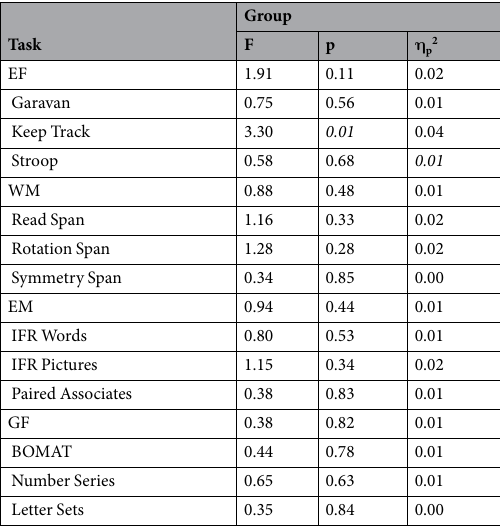
Table 1. ANCOVA Results for Constructs and Individual Transfer Tasks. Note: Values in italics indicate significant values (alpha = 0.05). EF = Executive Function. WM = Working Memory. EM = Episodic Memory. GF = Fluid Intelligence. IFR = Immediate Free